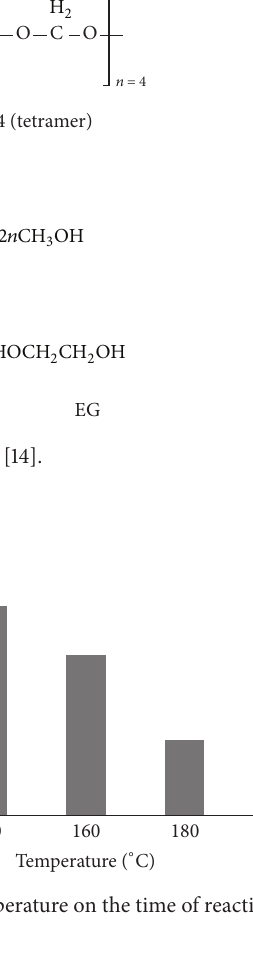
conversation of 98% was observed at 190 ∘ C in 10